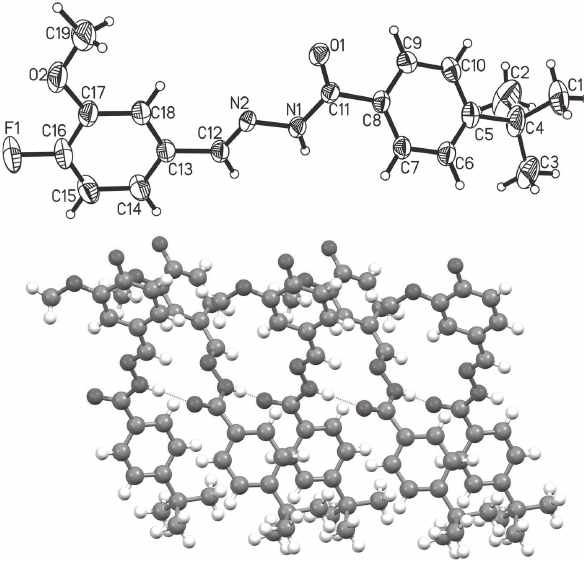
Table 1: Data collection and